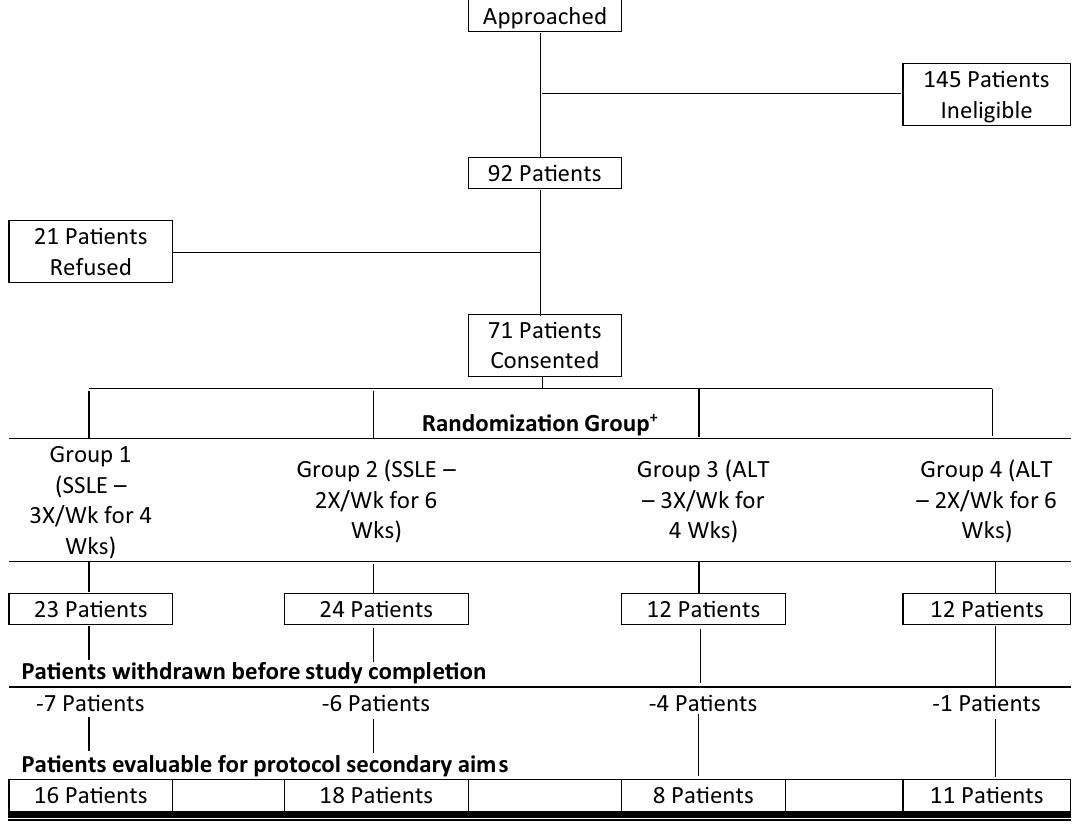
Figure 1. Oncology massage CIPN pilot consort diagram. +All patients randomized were considered evaluable for protocol primary aim. SSLE: Site specific lower extremity (primary intervention group). ALT: Alternate treatment site (head/neck/shoulder, control